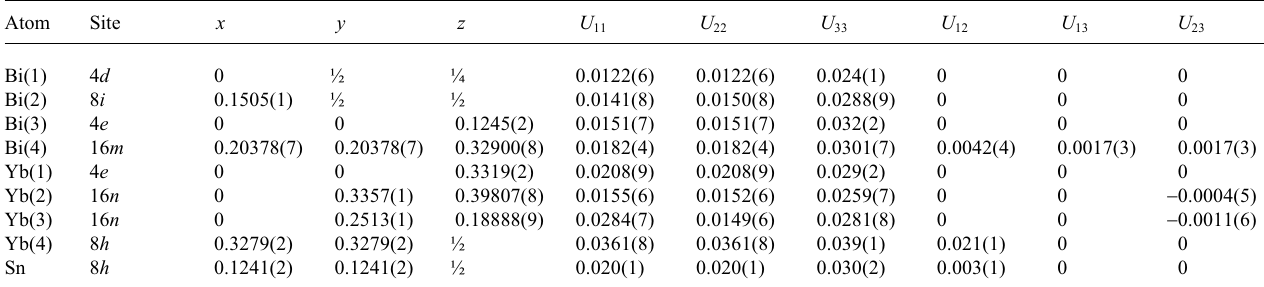
Table 2. Atomic coordinates and displacement parameters (in Å 2 )